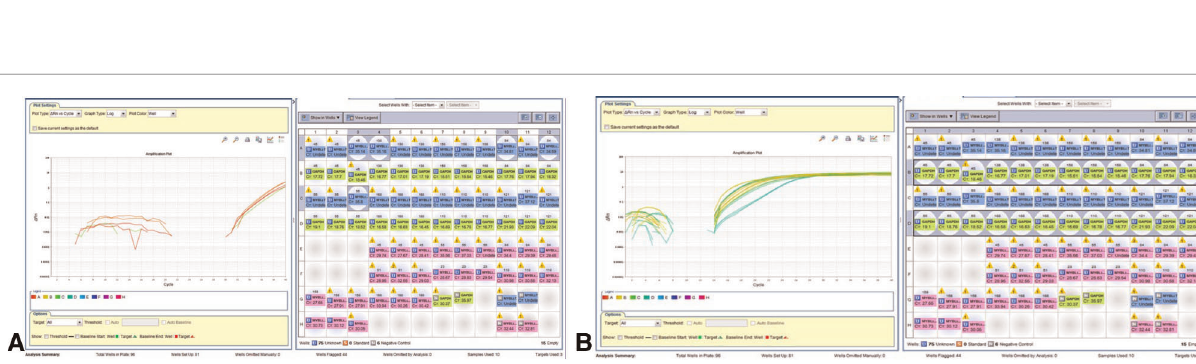
FIGURE 4 | MYBL-1 duplication – truncation by RT-PCR. Genomic DNA of Glioma grade II: Negative ( n =1): 60(55)-PXA. Positive ( n =8): 49 – 55 and 168. Key of gel order: 50(45) GG, 52(84) FA, 51 FA, 49(23) FA, 55(102) PMA, 53(110) PMA, 54(158) PXA, 168 ODG. Of note, sample 168 was negative on gel, although positive in RTPCR.